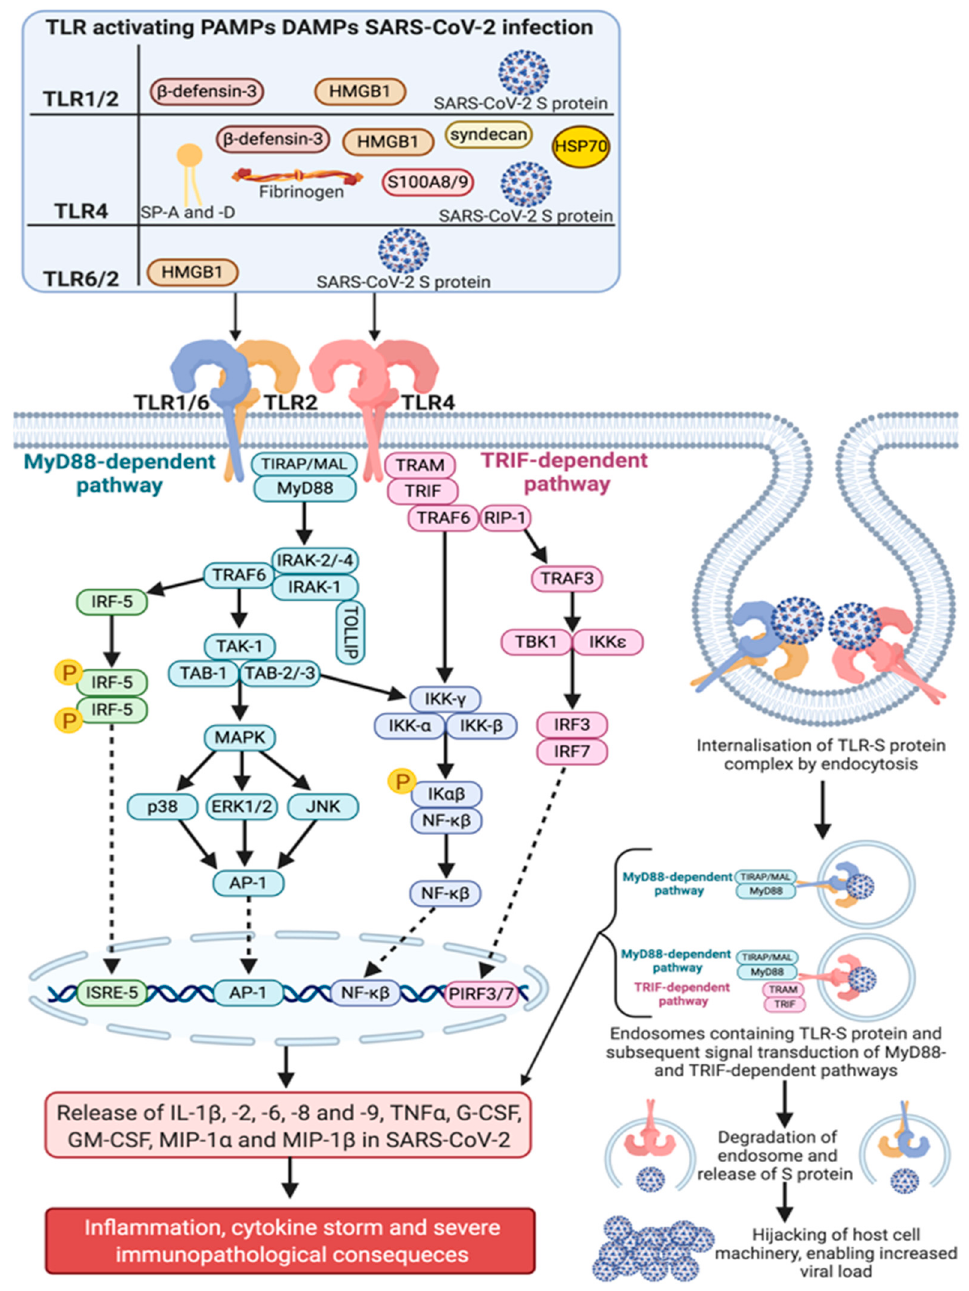
Figure 4. Proposed toll-like receptor 1, 4, and 6 involvement in SARS-CoV-2 infection into host cells. In silico studies have demonstrated direct binding between TLR1, 4, and 6 and the S1 interface of SARS-CoV-2 S protein [2], indicating that it may be a novel TLR pattern recognition receptor. Additionally, circulating TLR activating danger-associated molecular patterns (DAMP) have been reported in COVID-19 patients [94,96,100,128–133]. Activation by SARS-CoV-2 S protein and DAMPs may drive TLR mediated inflammation (through myeloid differentiation factor-88- and toll/IL-1-domain-containing adapter-inducing interferon-beta (TRIF)-dependent pathways) in patients with COVID-19 [144], manifesting as chronic inflammation, cytokine storm, and severe outcomes [100]. As such, we postulate that receptor-dependent internalization of the S protein may provide novel viral entry points, causing systemic spread independent of ACE2. Abbreviations: activator protein-1, AP-1; extracellular signal-regulated kinase, ERK; granulocyte colony-stimulating factor, G-CSF; granulocyte-macrophage colony-stimulating factor, GM-CSF; k protein 70, HSP70; inhibitor of nuclear factor kappa-beta kinase subunit, IKK; inositol-requiring enzyme-1 alpha, IRE1 𝛼 ; interferon regulatory factor, IRF; interferon stimulated response element, ISRE; in-